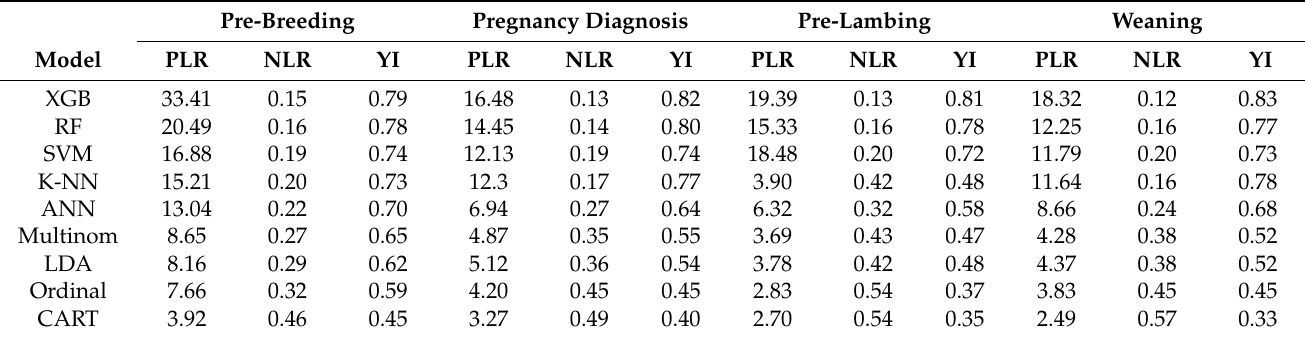
Table 4. Measures of the balance between sensitivity and specificity of the BCS prediction models by stage of the annual cycle. Pre-Breeding Pregnancy Diagnosis Pre-Lambing